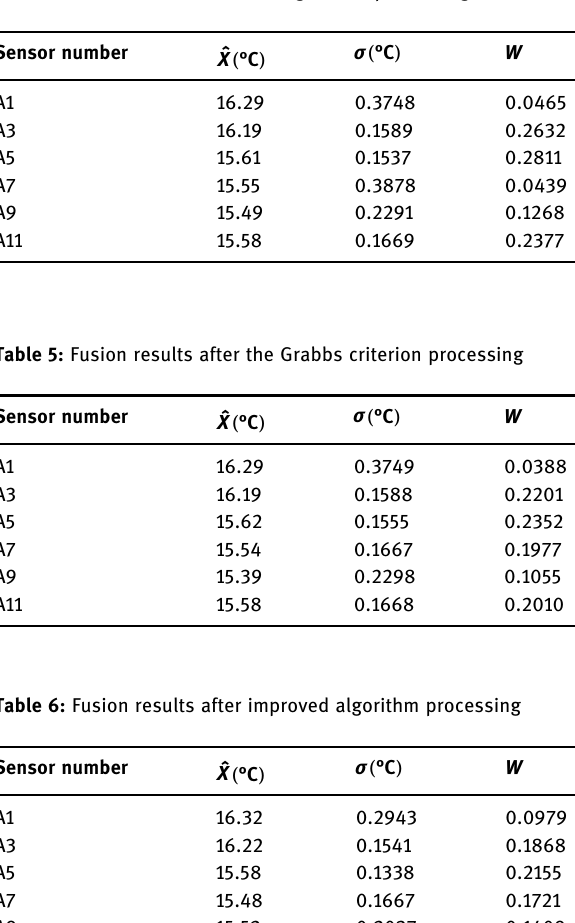
Table 4: Fusion results after average value processing